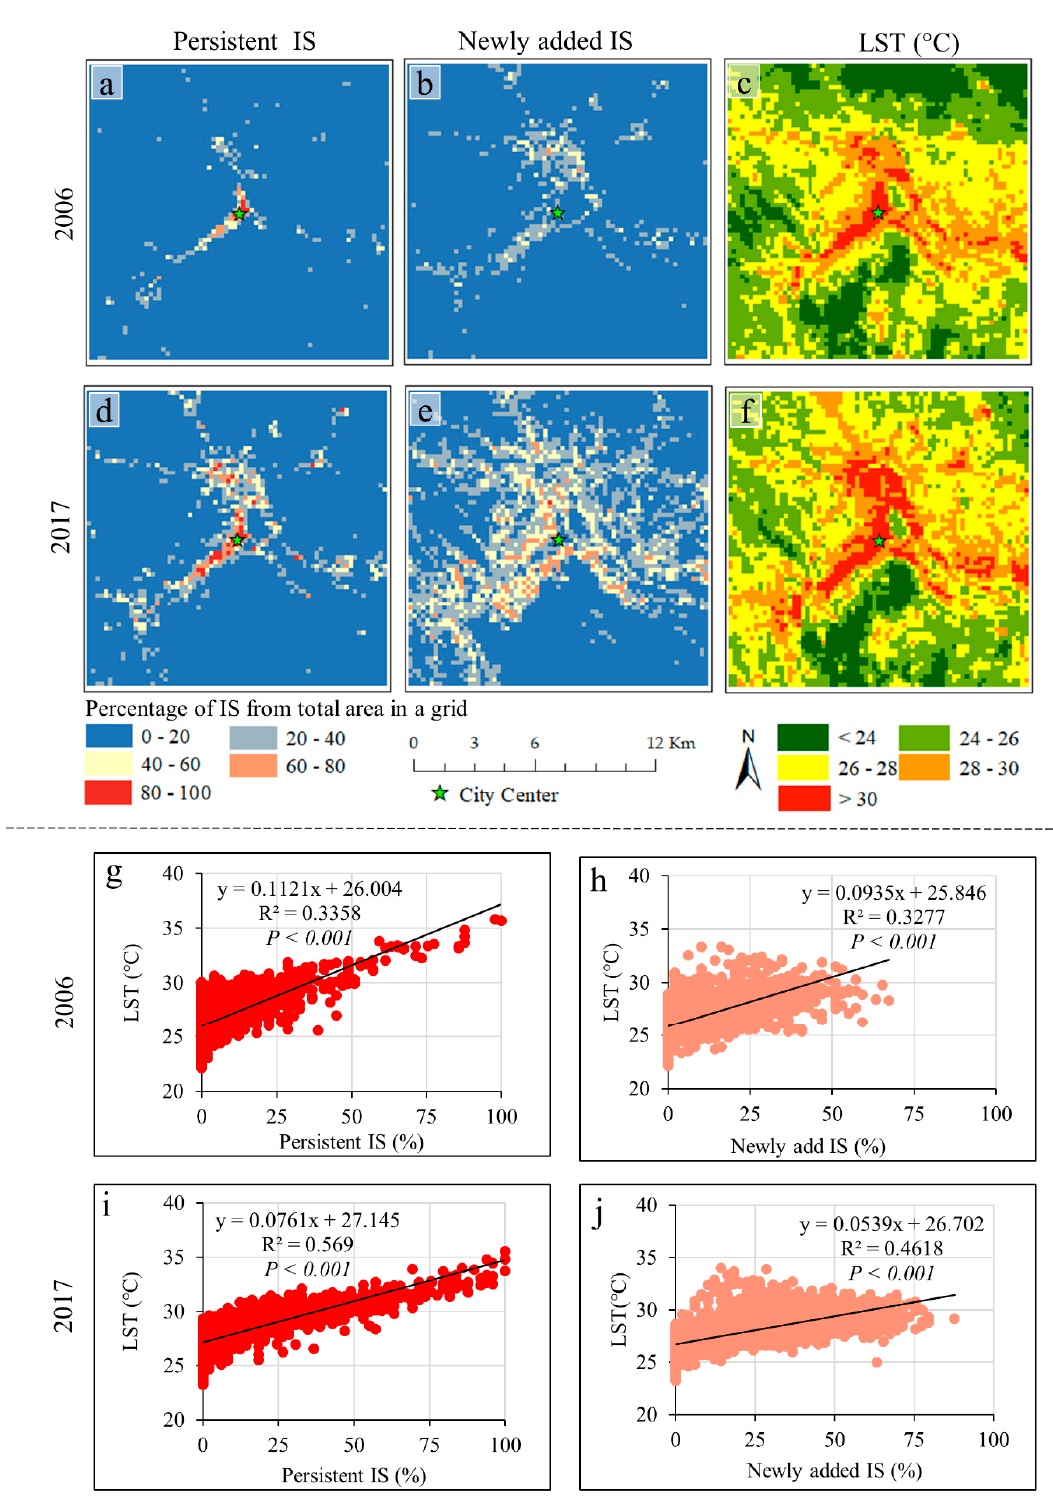
Figure 7. Relationships between IS and LST with 7 × 7 windows: ( a ) persistent IS in 2006; ( b ) newly added IS in 2006; ( c ) LST in 2006; ( d ) persistent IS in 2017; ( e ) newly added IS in 2017; ( f ) LST in 2017. Scatter plot diagrams ( g ) between LST and persistent IS in 2006, ( h ) between LST and newly added IS in 2006, ( i ) between LST and persistent IS in 2017, and ( j ) between LST and newly added IS in 2017.